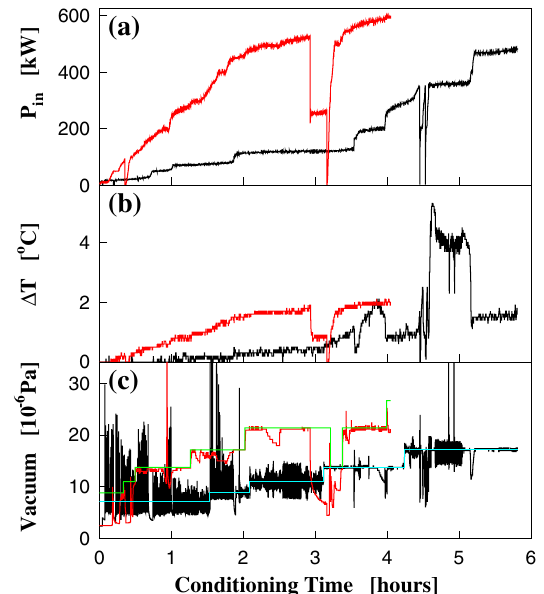
FIG. 14. Conditioning histories of an ungrooved coupler (black) and the first grooved coupler (red), where a conditioning time of 0 indicates the start of the first conditioning for both couplers, on the (a) input rf power, (b) temperature difference of the cooling water between into and out of the outer conductor of the coaxial line, and (c) vacuum pressure. The green (light blue) line in (c) indicates the reference vacuum pressure specified in the automatic conditioning of the grooved (ungrooved) coupler by computer control. If the vacuum pressure is higher than the reference, the power is slightly stepped down until the vacuum pressure becomes lower than the reference, and then the power is slightly stepped up as long as the vacuum pressure is lower than the reference. After keeping the input rf power with the same reference, the vacuum pressure gradually decreases, and more power can be input. This process is known as ‘‘conditioning,’’ where gradual increases of the reference are required at higher input rf powers due to the greater rf surface heating. The sudden power drop about three hours after the start of conditioning for the grooved coupler was caused by the klystron